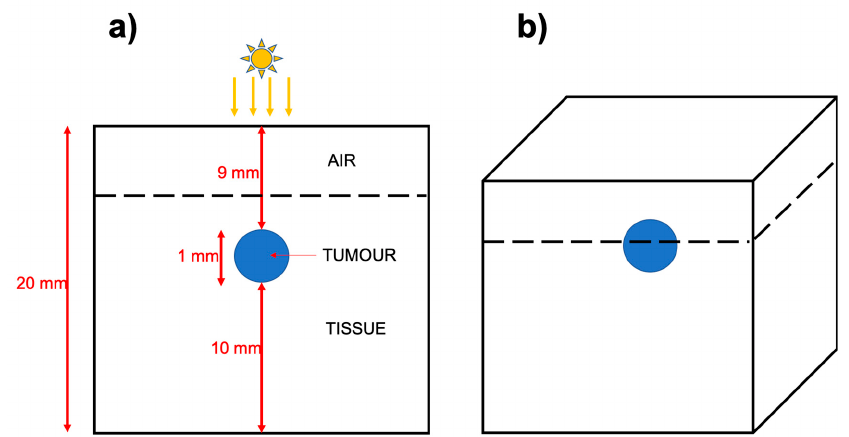
Figure 1. Schematic showing the dimensions of the simplified skin cancer model. ( a ) A two-dimension (2D) slice through the simulated world, which is a cartesian grid illustrated in ( b ). The light source is 1 W and has a radius of 3 mm and is set to irradiate the top and centre of the model. In the simulations, we compare a control, to a tumour infused with gold nanorods, with the absorbance and scattering values (respectively μ a and μ a ) shown in Table 1.